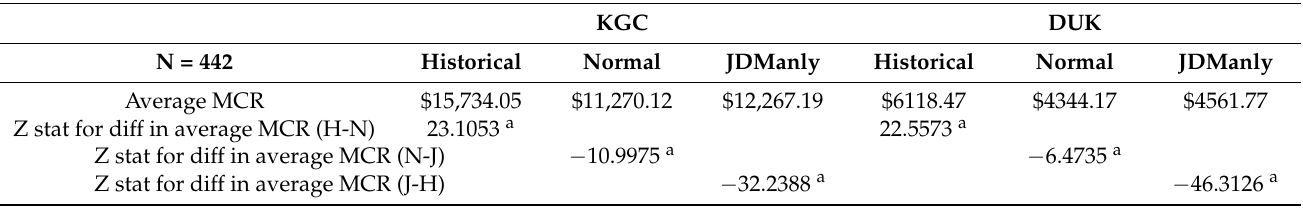
Table 5. Minimum capital requirements (MCR) based on value-at-risk estimates from the three models. Panel A. Results for the KGC and DUK stocks from the US market, based on 60 day rolling averages. For exemplification